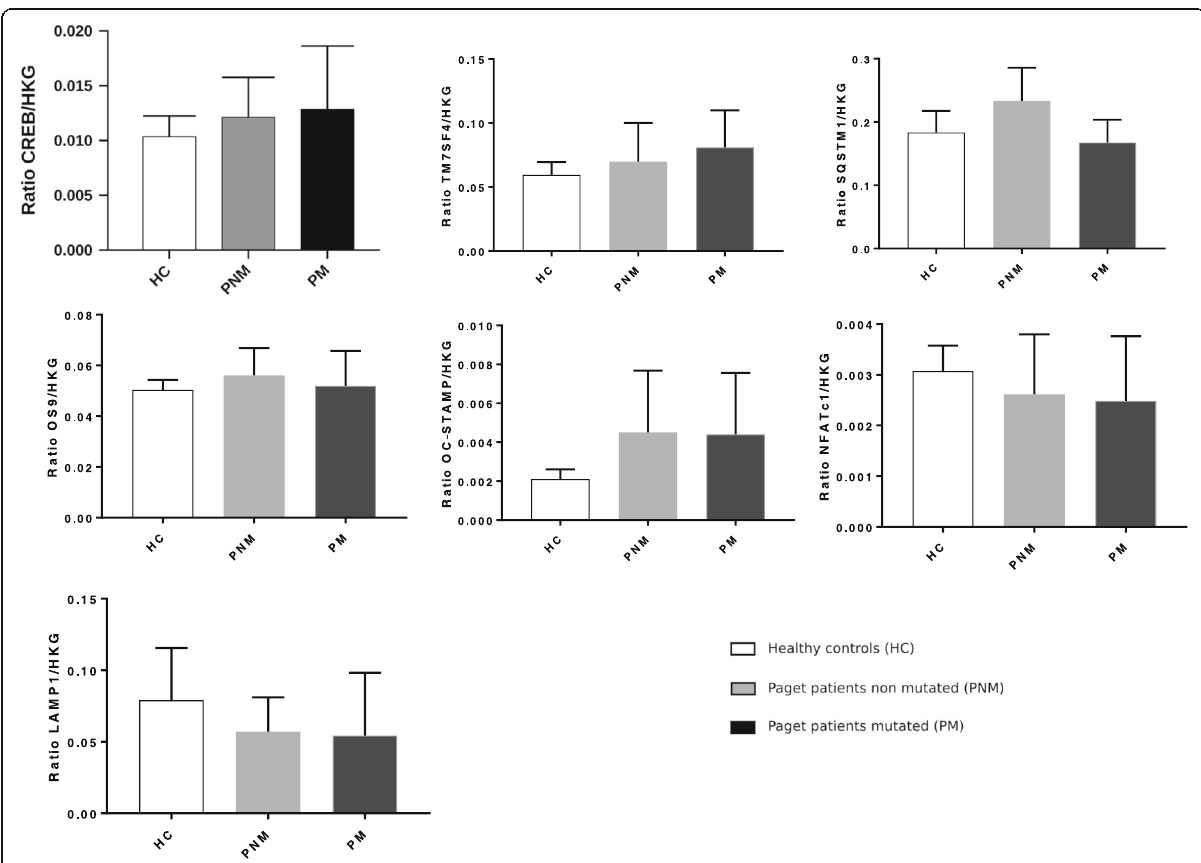
Fig. 3 Gene expression analyses of candidate genes quantified by PCR from cell lysates of in vitro differentiated osteoclasts and normalized by the geometric mean of the three housekeeping genes. Footnote: The ratio corresponds to the ratio of the studied gene expression by the geometric mean of the gene expression of the three housekeeping